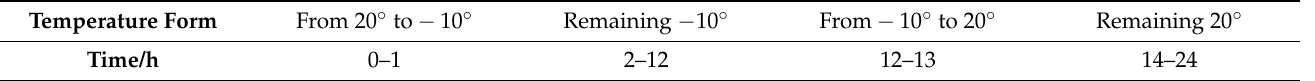
Table 2. The form of the F–T